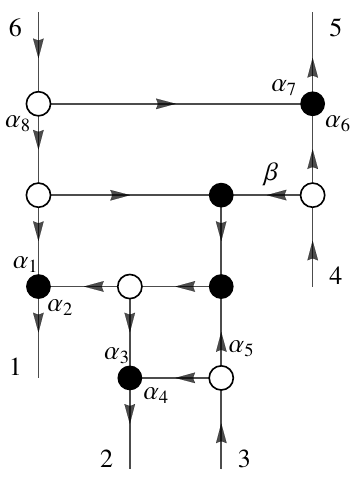
Figure 11 . The 5+3 channel BCFW diagram contributing to the 6 point NMHV in N = 4 SYM. Edge variables are denoted as (cid:11) i . The label (cid:12) is not an edge